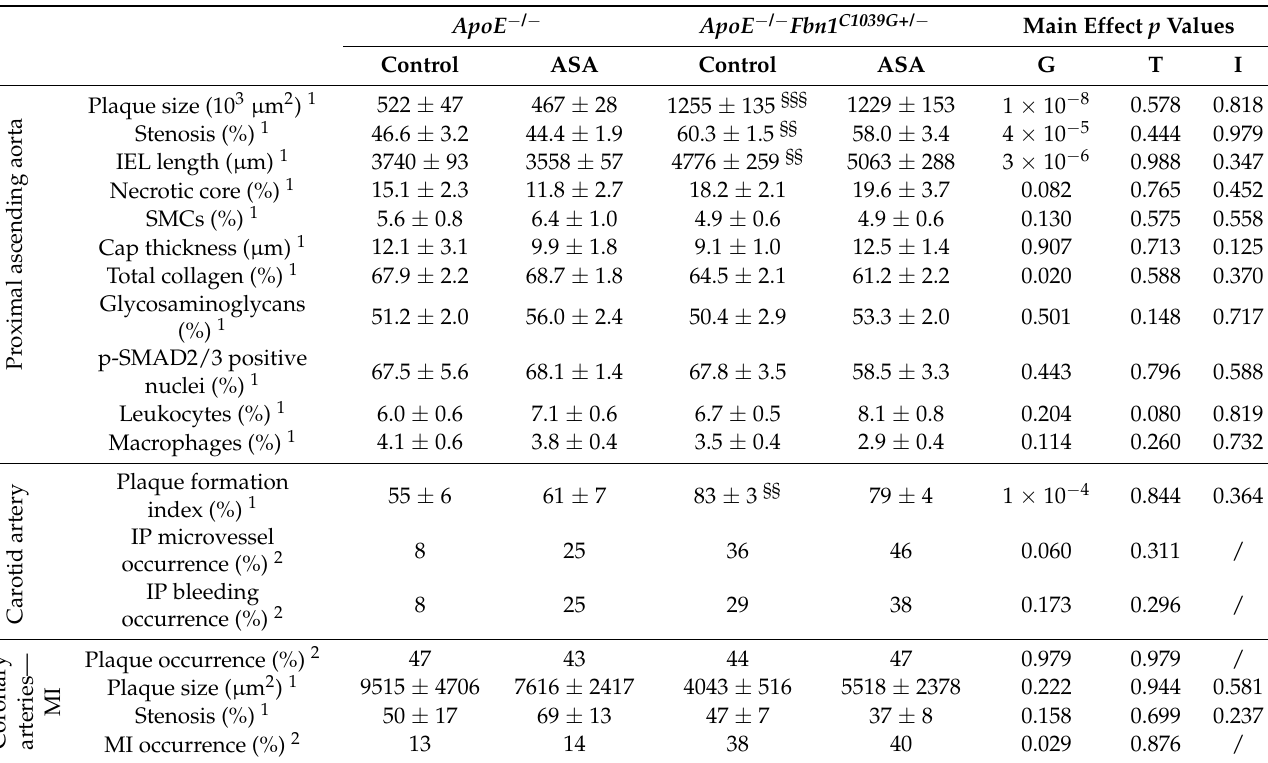
Table 3. Atherosclerotic plaque and MI